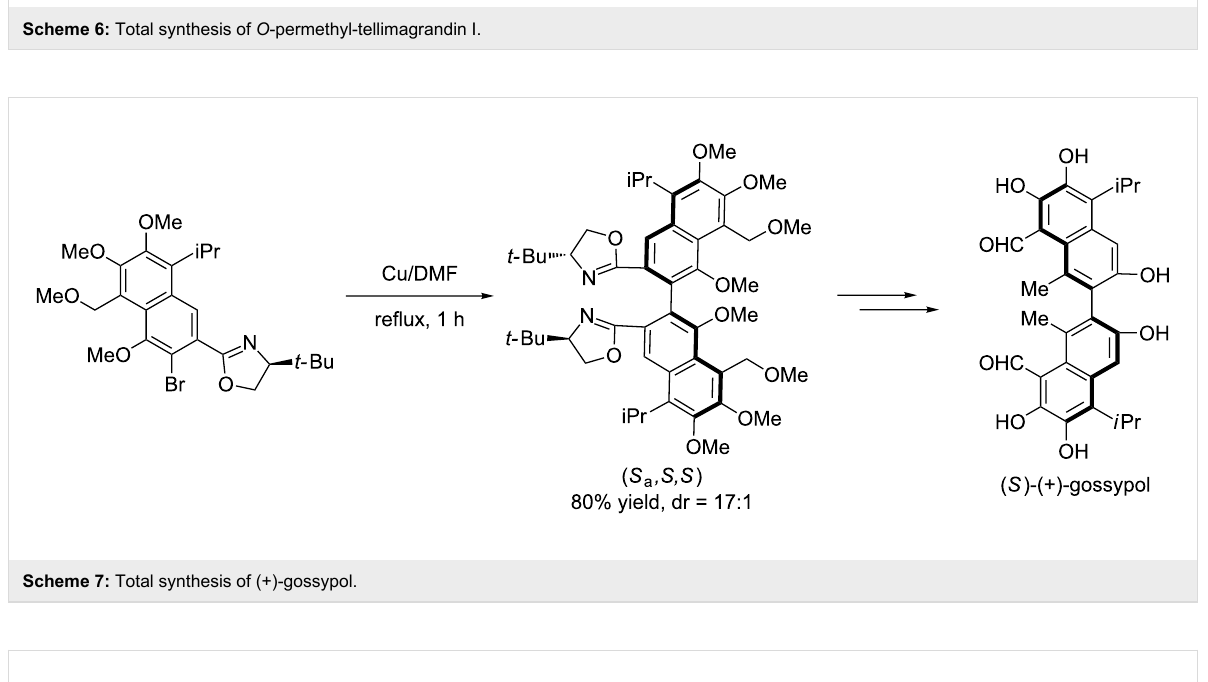
Scheme 6: Total synthesis of O -permethyl-tellimagrandin I.